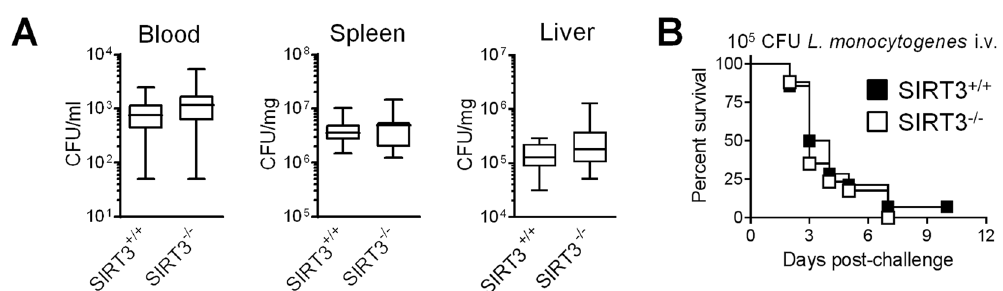
Figure 4. SIRT3 deficiency does not impact on organ colonization and survival of mice infected with L . monocytogenes . SIRT3 + / + and SIRT3 − / − mice ( A ) n = 14–15 per group; ( B ) n = 14–16 per group) were injected i.v. with 10 5 CFU L . monocytogenes . (( A ) Blood, spleen and liver were collected 48 hours after challenge to quantify bacterial loads. P = 0.02, 0.8 and 0.1. ( B ) Survival of mice. P = 0.5.